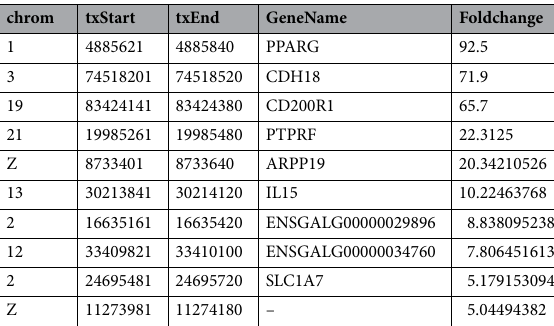
Table 2. Top ten down-methylated peaks of differentially m 6 A methylated sites in the infected group. “–” represents not available . Chrom: Chromosome; TxStart/TxEnd: Start/end position of the differentially methylated RNA peaks.